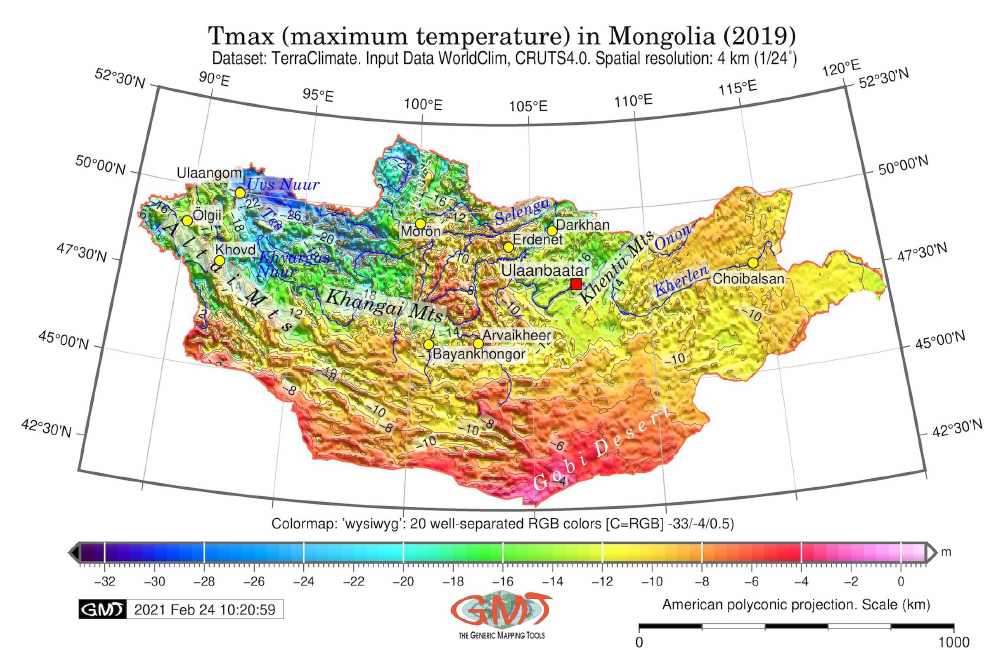
Figure 3. Average maximal temperature in Mongolia in April 2019. Mapping: GMT by script available in Appendix B.2. Source: